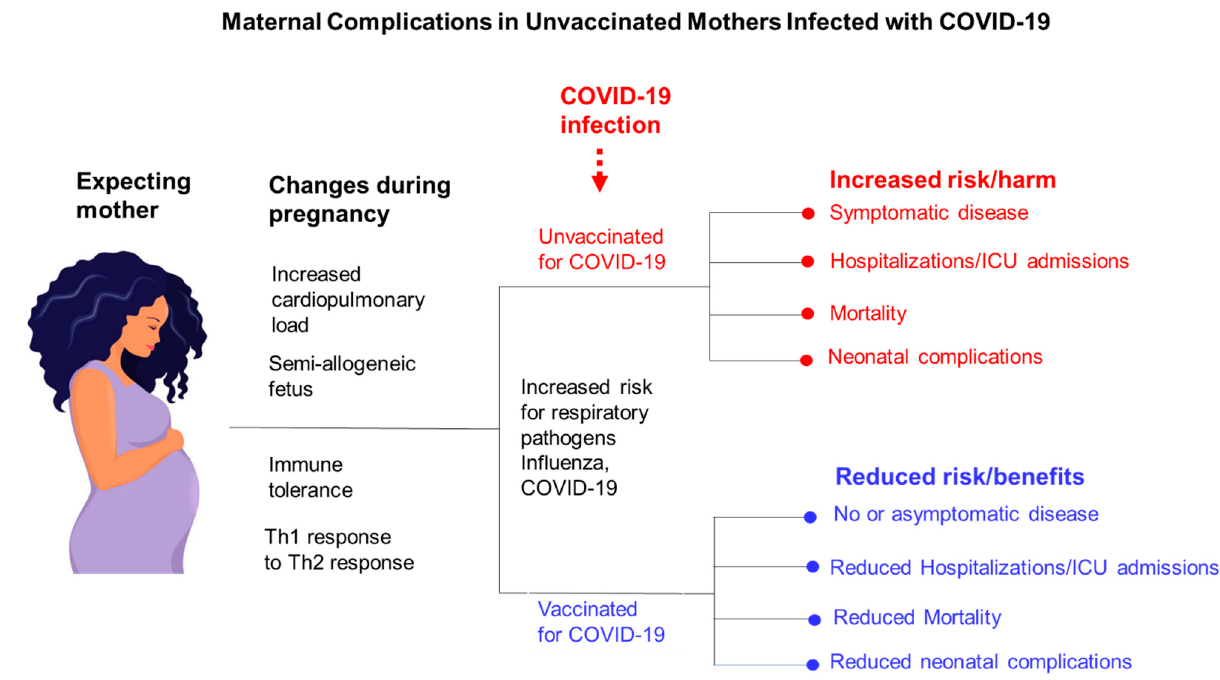
Figure 2. Maternal complications in unvaccinated mothers infected with COVID-19.